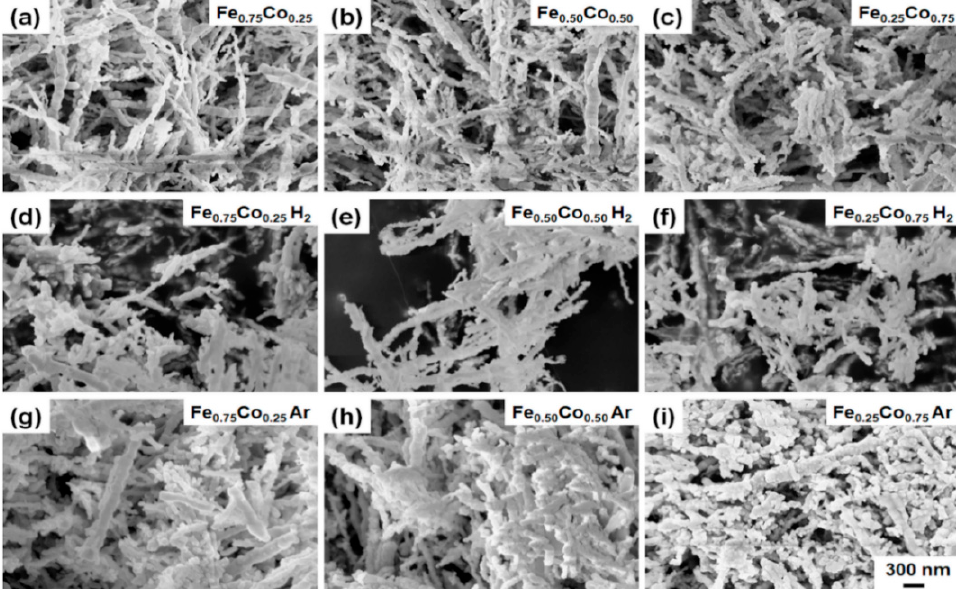
Figure 1. SEM images of as-prepared ( a ) Fe 0.75 Co 0.25 , ( b ) Fe 0.50 Co 0.50 , and ( c ) Fe 0.25 Co 0.75 Wire-like nanochains; SEM images of ( d ) Fe 0.75 Co 0.25 , ( e ) Fe 0.50 Co 0.50 , and ( f ) Fe 0.25 Co 0.75 Wire-like nanochains annealed in hydrogen-containing atmosphere; SEM images of ( g ) Fe 0.75 Co 0.25 , ( h ) Fe 0.50 Co 0.50 , and ( i ) Fe 0.25 Co 0.75 Wire-like nanochains annealed in argon.